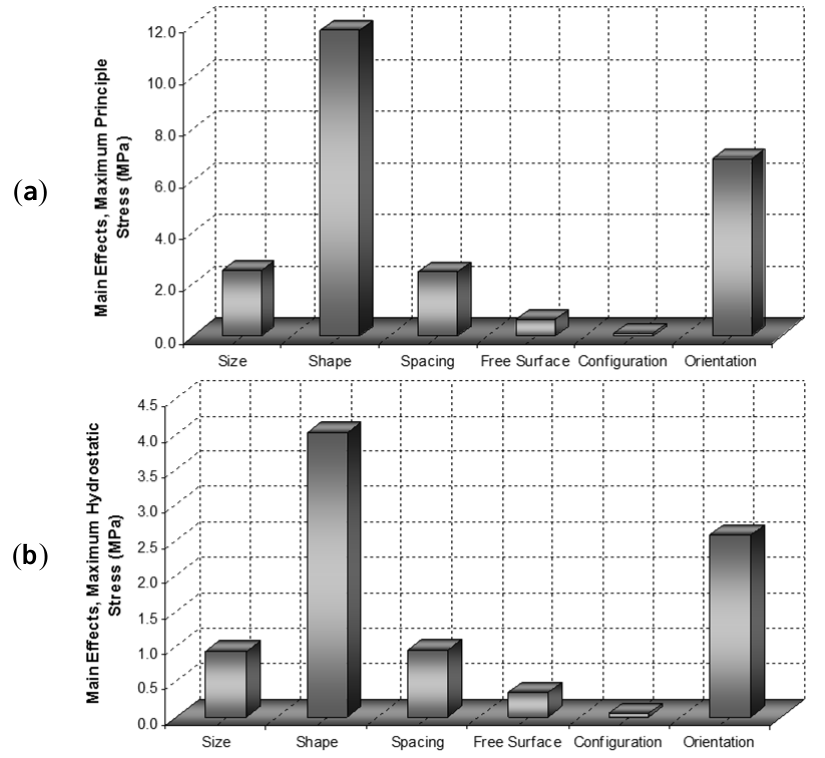
Figure 25. The influence of casting parameters on ( a ) Maximum principal stress; ( b ) Maximum hydrostatic stress (all the particles are fully bonded to the matrix) [13].